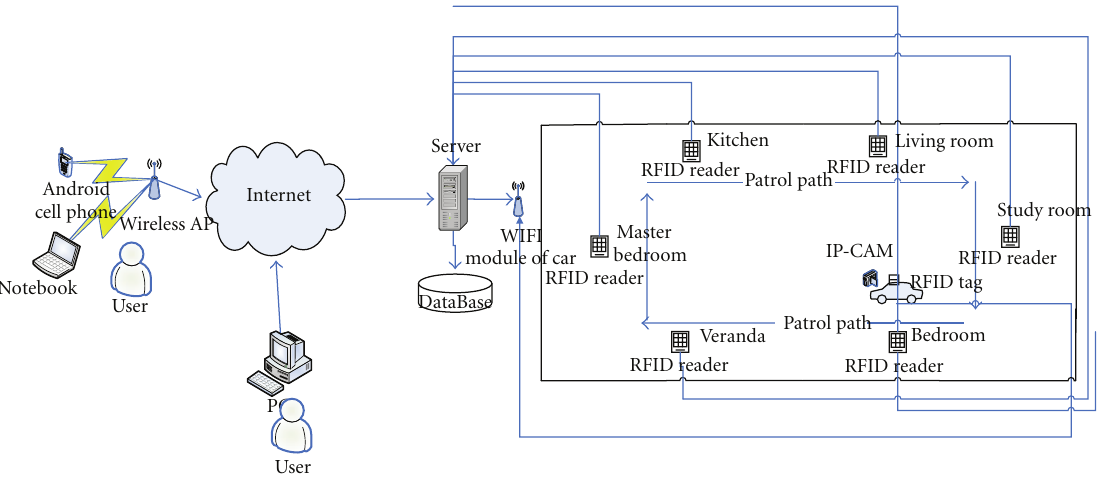
Figure 3: The architecture of the proposed system.